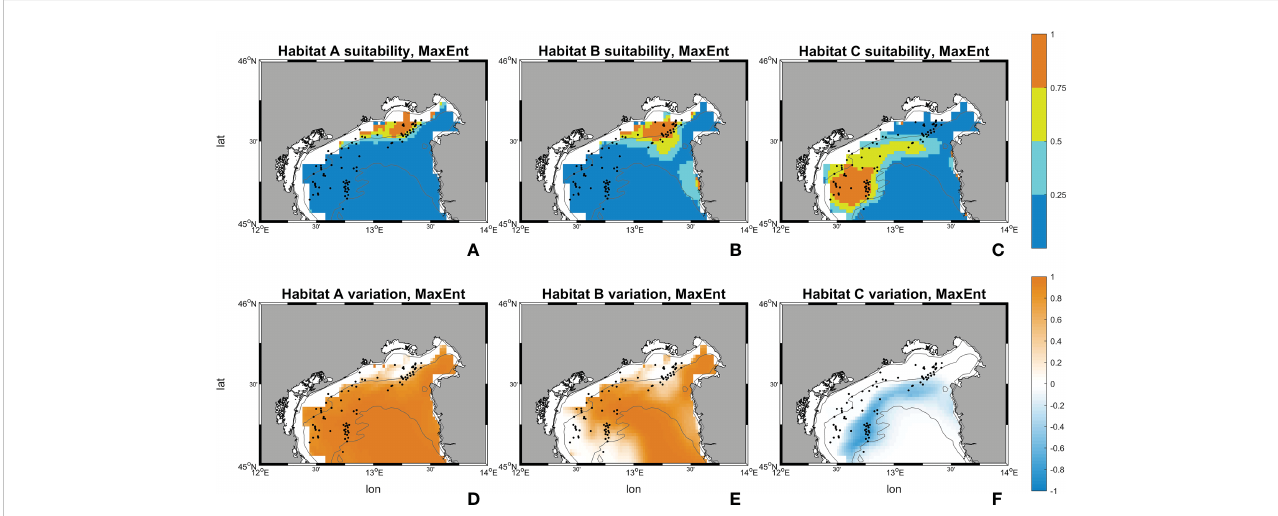
FIGURE 11 Suitability maps (horizontal resolution 0.02°) from MaxEnt. Maps (A – C) represents MaxEnt suitability for habitat A, B and C during the historical period (1999-2018). Maps (D – F) represents MaxEnt future changes according to climate change RCP 8.5 scenario. First line scale legend: 0-0.25 = Low suitability; 0.25-0.5 = Moderate suitability; 0.5-0.75 = High suitability; 0.75-1 = Very high suitability (Thuiller and Münkemüller, 2010; Mousazade et al., 2019). Second line scale legend: -1 = prediction of a suitability decrement in comparison to historical period; 0 = no changes predicted; +1 = prediction of a suitability increment in comparison to historical